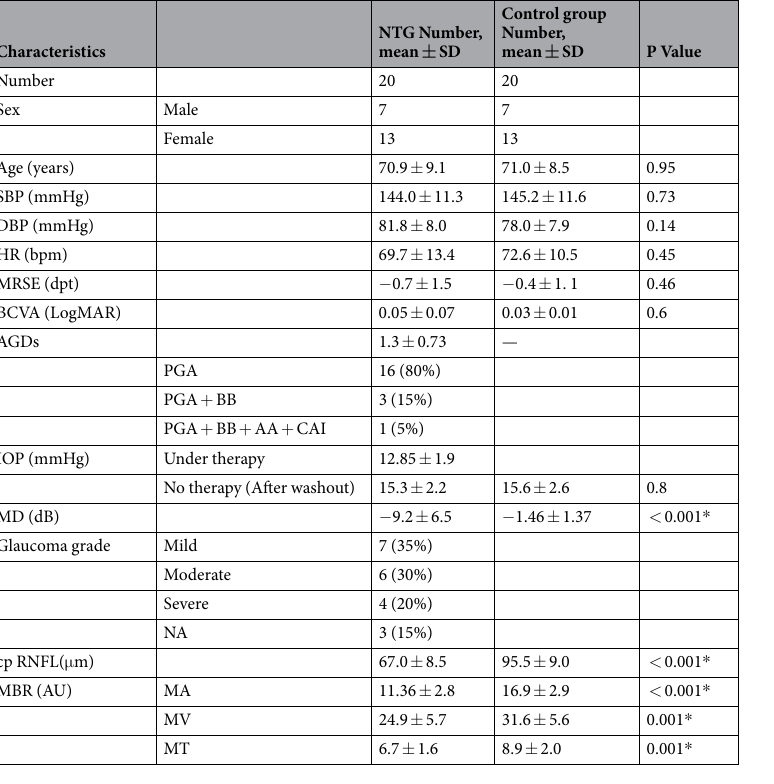
Table 1. Baseline characteristics and Mean Blur Rate in normal tension glaucoma group and control group including biometric results. Glaucomatous damage was graded into groups according to the visual field impairment 30 . (NTG) Normal tension glaucoma. (SD) Standard deviation. (MBR) Mean blur rate. (SBP) Systolic blood pressure. (DBP) Diastolic blood pressure. (HR) Heart rate. (bpm) Beats per minute. (BCVA) Best corrected visual acuity. (AGDs) Antiglaucomatous drugs. (PGA) Prostaglandin-analogue monotherapy. (PGA + BB) Combination of prostaglandin analogue and beta blocker. (PGA + BB + AA + CAI) Combination of prostaglandin analogue, beta blocker, alpha agonist and carbonic anhydrase inhibitor. (IOP) Intraocular pressure. (MD) Mean deviation of visual field. (NA) Not applicable. (cpRNFL) Circumpapillary retinal nerve fibre layer. (AU) Aberration units. (MA) MBR in all area of interest. (MV) MBR in area of big vessels. (MT) MBR in area of microvasculature. ( * Marks statistical